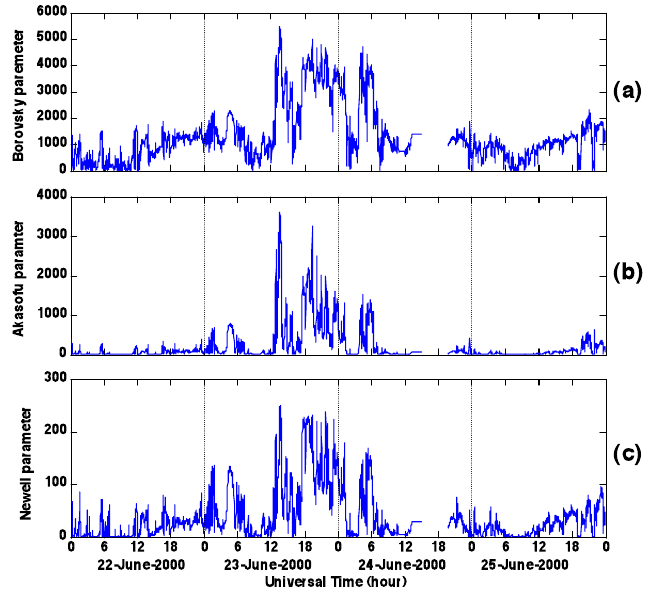
. (b) IMF B . (c) Dawn-to-dusk component of z y . (d) SYM-H index. (e) ASY-H index. y